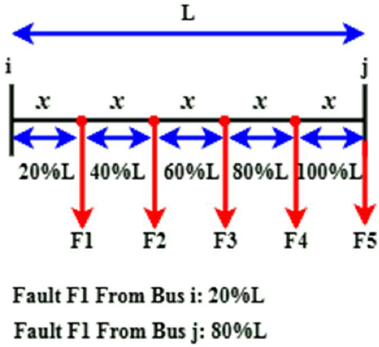
Figure 10. Fault between two buses i , j .